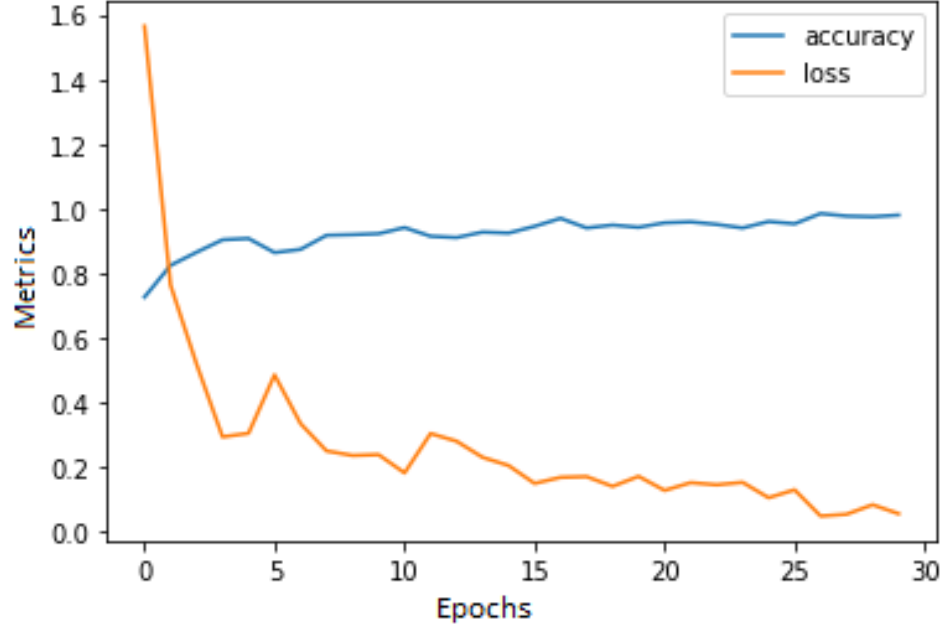
Figure 10. Loss and accuracy vs. epochs during training.